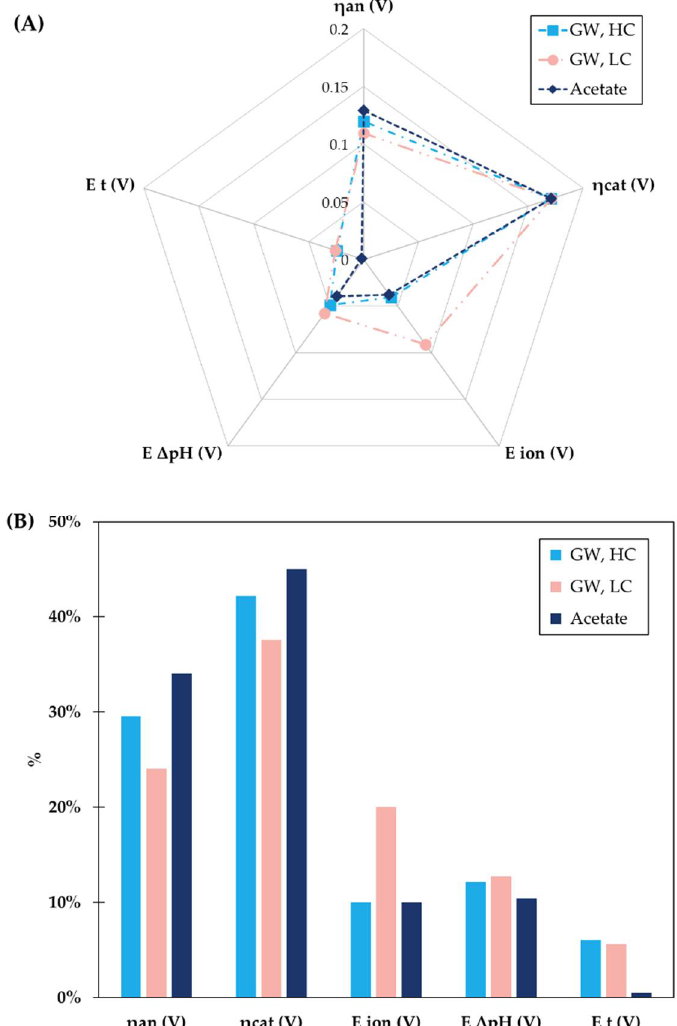
Figure 5. Energy losses in the different conditions. ( A ) distribution of the internal losses; ( B ) percentage of the internal losses. GW, LC: greywater, low conductivity; GW, HC: greywater, high conductivity; acetate was used as anode feed in the control reactor. E t : membrane transport losses; E ∆pH : pH overpotential; η an : anode overpotential; η cat : cathode overpotential; E ion : ionic overpotential. Table 2. Maximum voltage measured, current density and power densities obtained from polarization curves, normalized energy recovery, and COD removal in the experimentation.